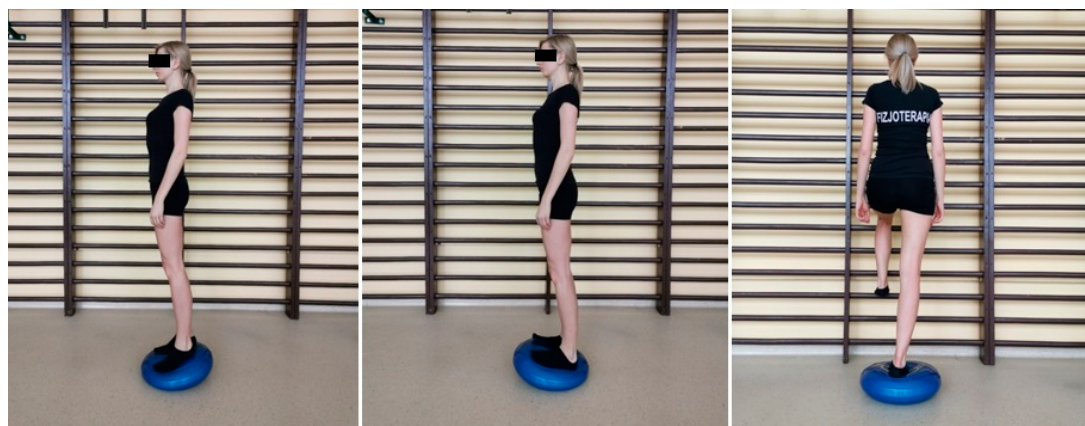
Figure 3. Exercises on the sensorimotor cushion.